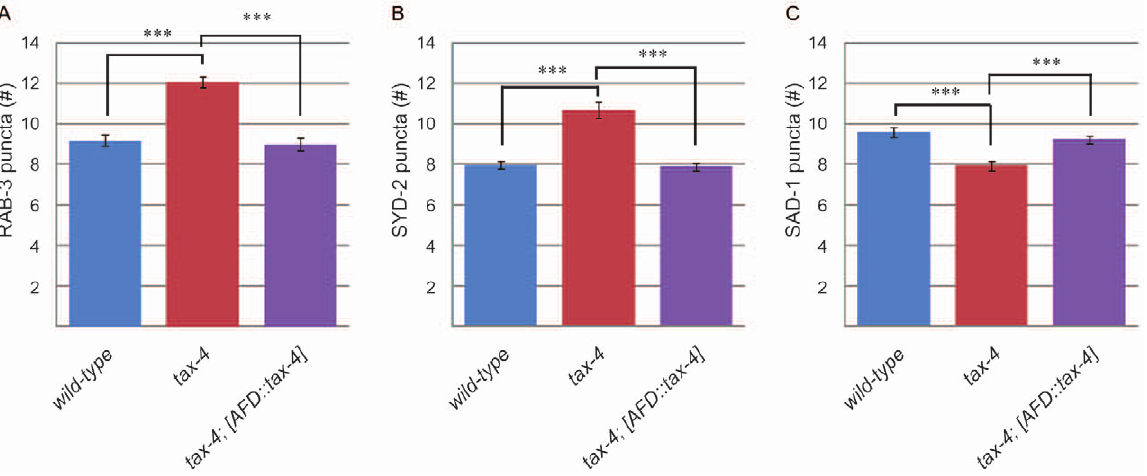
Figure 4. Cell-autonomous rescue of tax-4 . (A) Number of RAB-3 puncta in 50 or more wild-type animals, tax-4 animals, and tax-4 animals expressing tax-4 specifically in AFD. (B) Number of SYD-2 puncta in 50 or more wild-type animals, tax-4 animals, and tax-4 animals expressing tax-4 specifically in AFD. (C) Number of SAD-1 puncta in 50 or more wild-type animals, tax-4 animals, and tax-4 animals expressing tax-4 specifically in AFD.